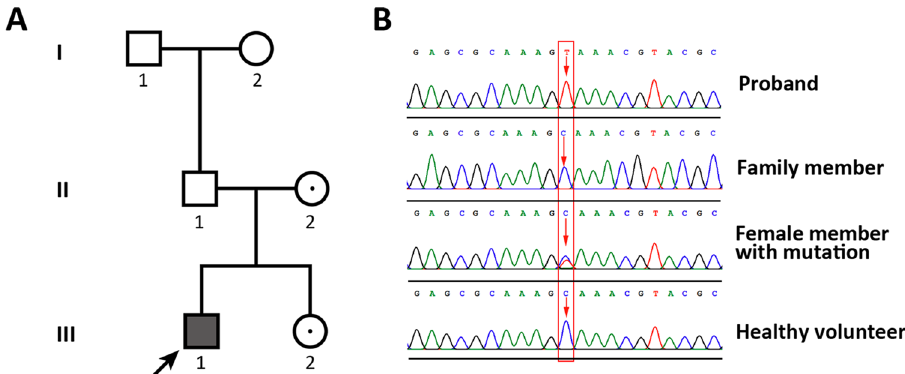
Figure 1. Family pedigree and variant screening analysis. ( A ) Family history of the three-generation family. Dark symbols represent the affected members, and clear symbols represent the unaffected members, among them, a dot in a clear symbol represents an unaffected member with a heterozygous gene variant. A square indicates a male and a circle indicates a female. ( B ) Screening of the variant site in the family and healthy volunteers is shown in ( A ) by sequencing analysis. The red frame indicates the variant